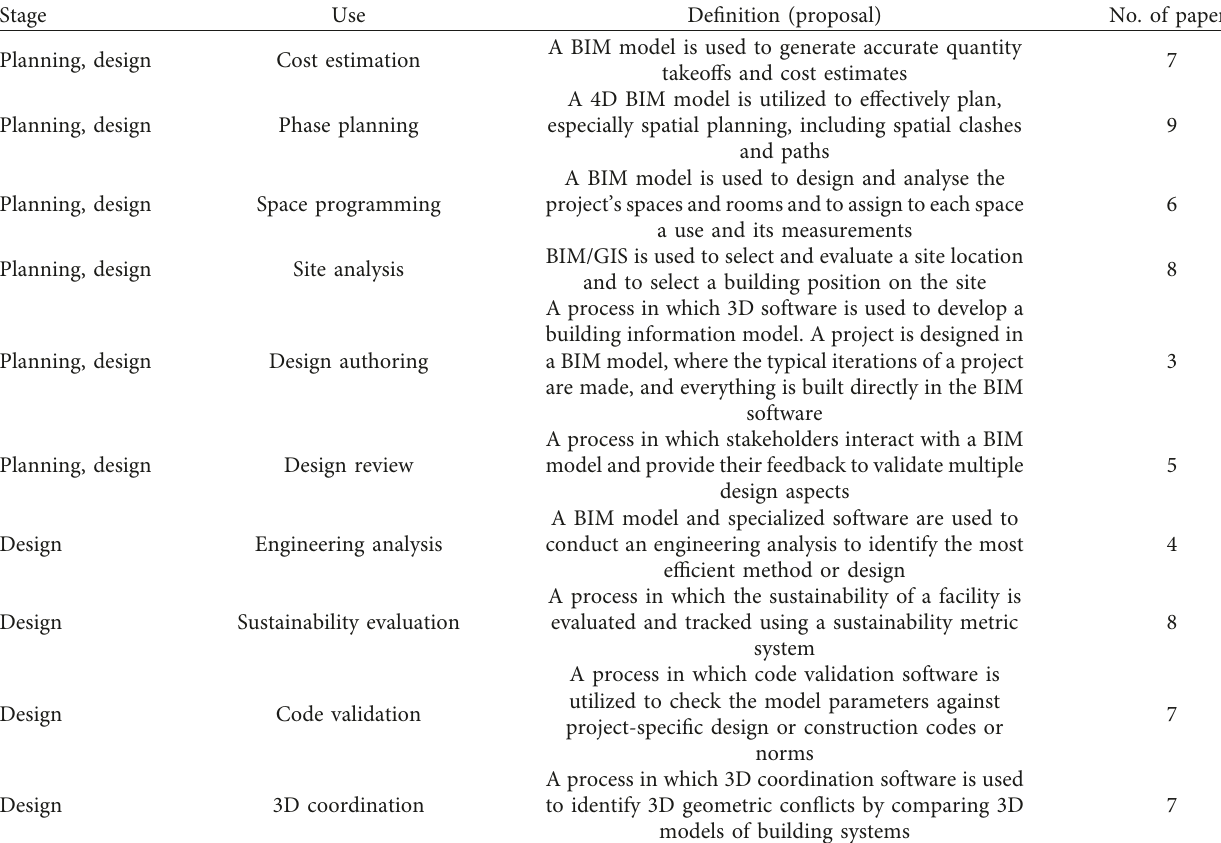
Table 4: Definitions of BIM uses for planning and design.